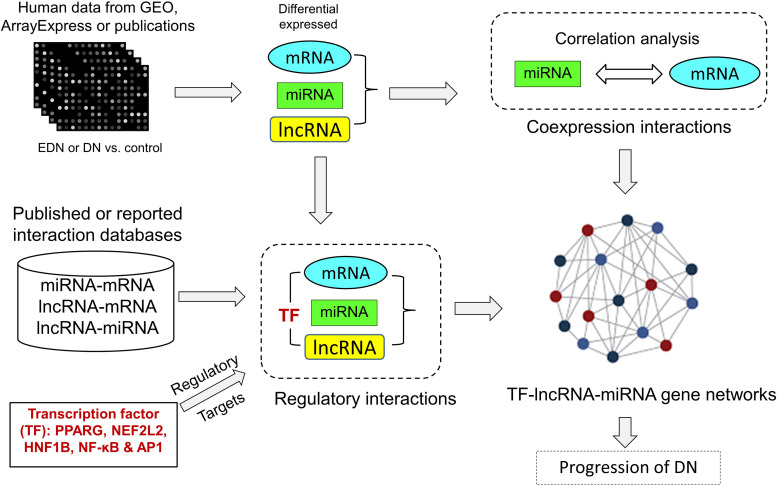
A pipeline analysis to identify interactions among TFs, lncRNAs, miRNAs, and mRNAs under DN. It includes three steps: (1) calculation of co-expression interactions between miRNAs and mRNAs from PCC analysis of DEG and DEM expression profiles obtained from EDN and DN datasets; (2) determination of interactive links among lncRNA–mRNAs or lncRNA–miRNAs generated by searching for lncRNA-targets (miRNA and mRNA) and miRNA–mRNAs; and (3) identification of TF–lncRNA–miRNA gene regulatory networks built from information generated in steps 1 and 2 and integrated with TF binding target data. PCC, Pearson correlation coefficient; DEG, differentially expressed genes/mRNAs; DEMs, differentially expressed miRNAs.